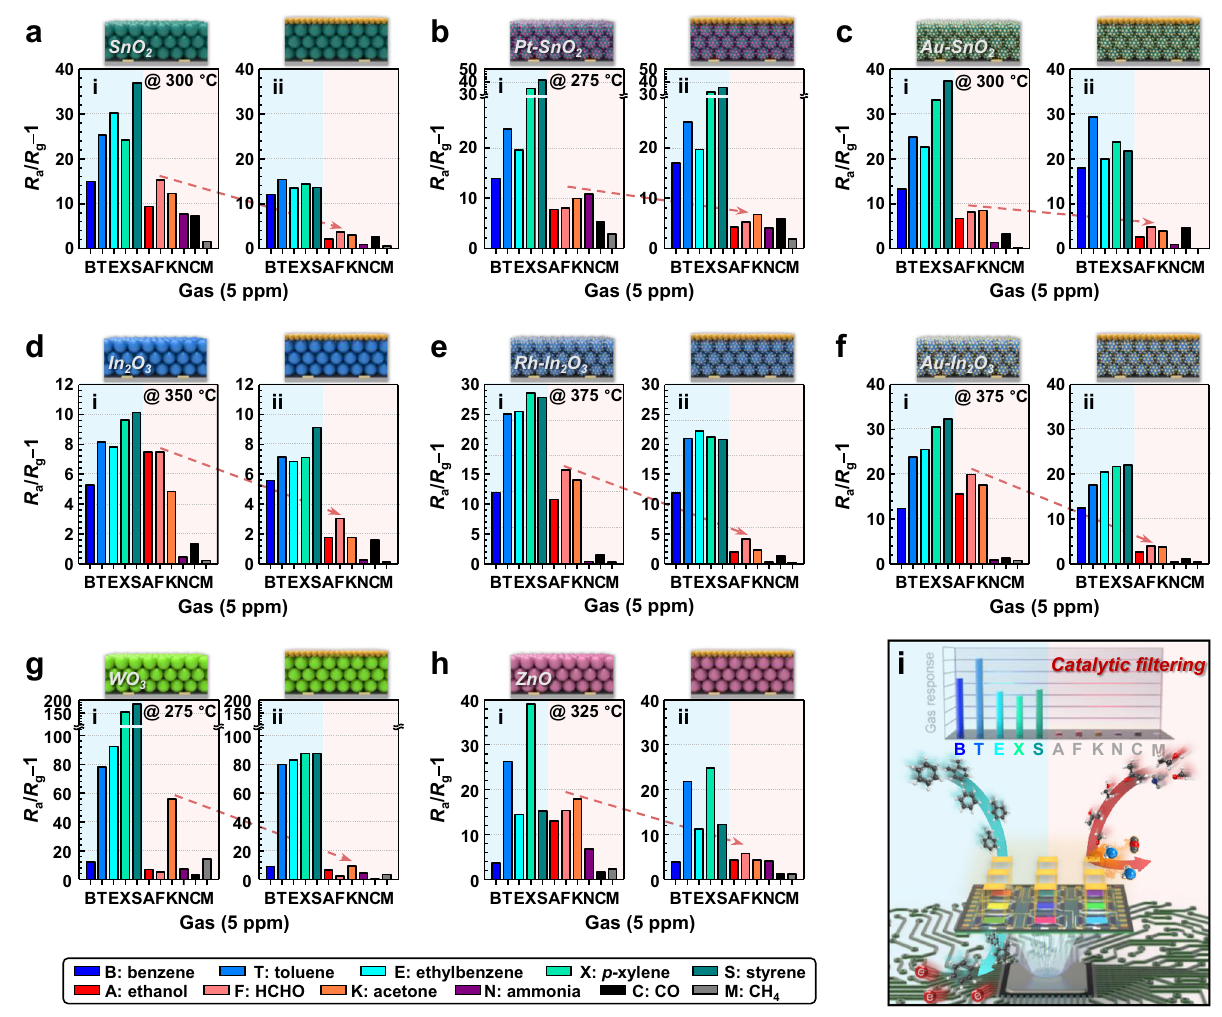
Fig. 8 | Gas responses for diverse sensors at optimal operation temperature. a – h Response properties of diverse (i) single-layer sensors and (ii) CeO 2 -coated bilayer sensors (sensing layer material: SnO 2 ( a ), Pt – SnO 2 ( b ), Au – SnO 2 ( c ), In 2 O 3